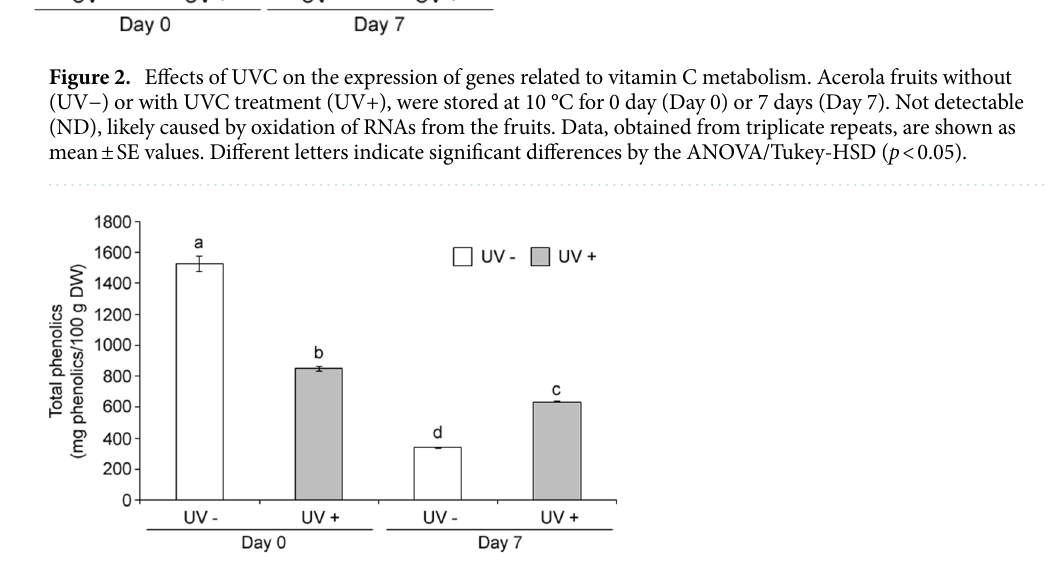
Figure 3. Effect of UVC on the content of total phenolic compounds. Acerola fruits without (UV−) or with UVC treatment (UV+), were stored at 10 °C for 0 day (Day 0) or 7 days (Day 7) and subjected to quantification of total phenolic compounds by LC–MS analysis (Table 1). Data, obtained from at least three biological repeats, are shown as mean ± SE values. Different letters indicate significant differences by the ANOVA/Tukey-HSD ( p <